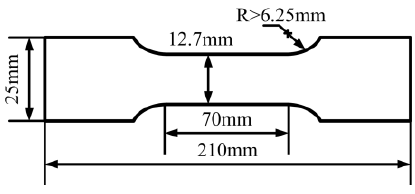
Figure 4. Dimensions of the tensile specimen.